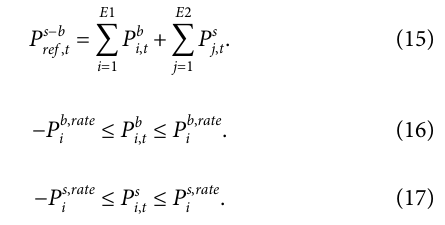
TABLE 1 | Charge and discharge power segmentation basis. Power of charge and discharge